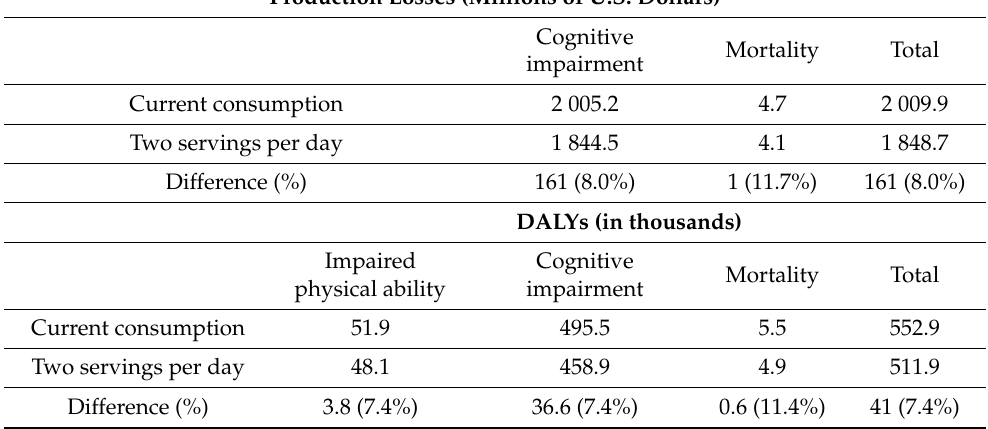
Table 5. Impact on the burden of IDA if all 6–23-month infants and young children consumed two servings per day of fortified infant